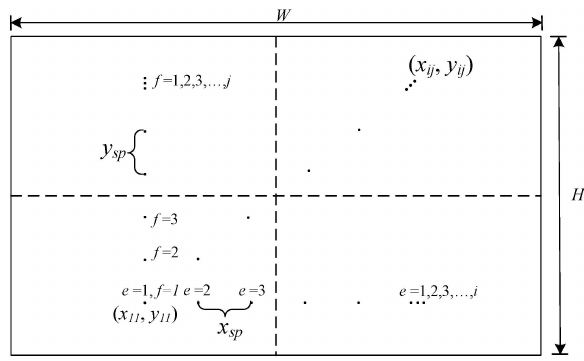
Figure 4. The reference points with a symmetrical pattern for IMU-aided motion